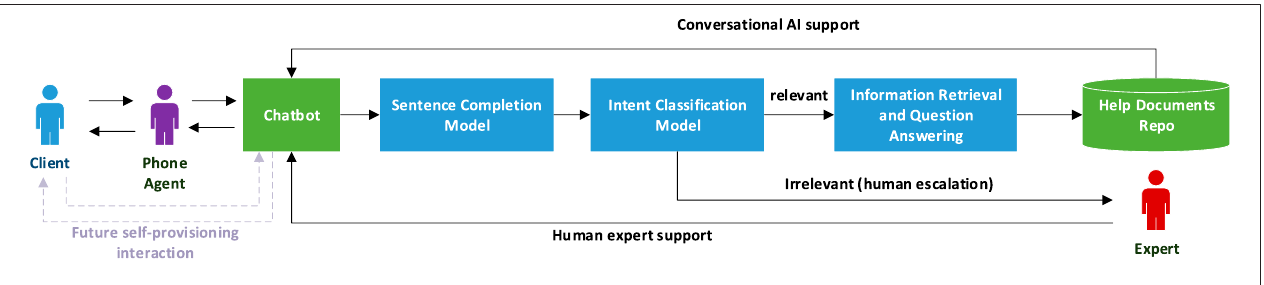
FIGURE 1 | End-to-end conceptual diagram of AVA.